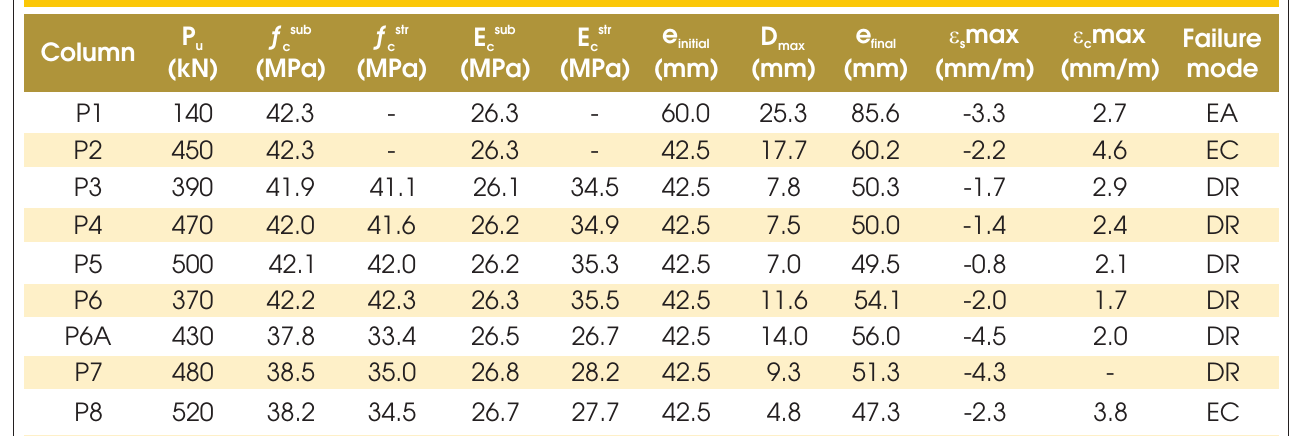
Table 2 – Failure loads and modes of all